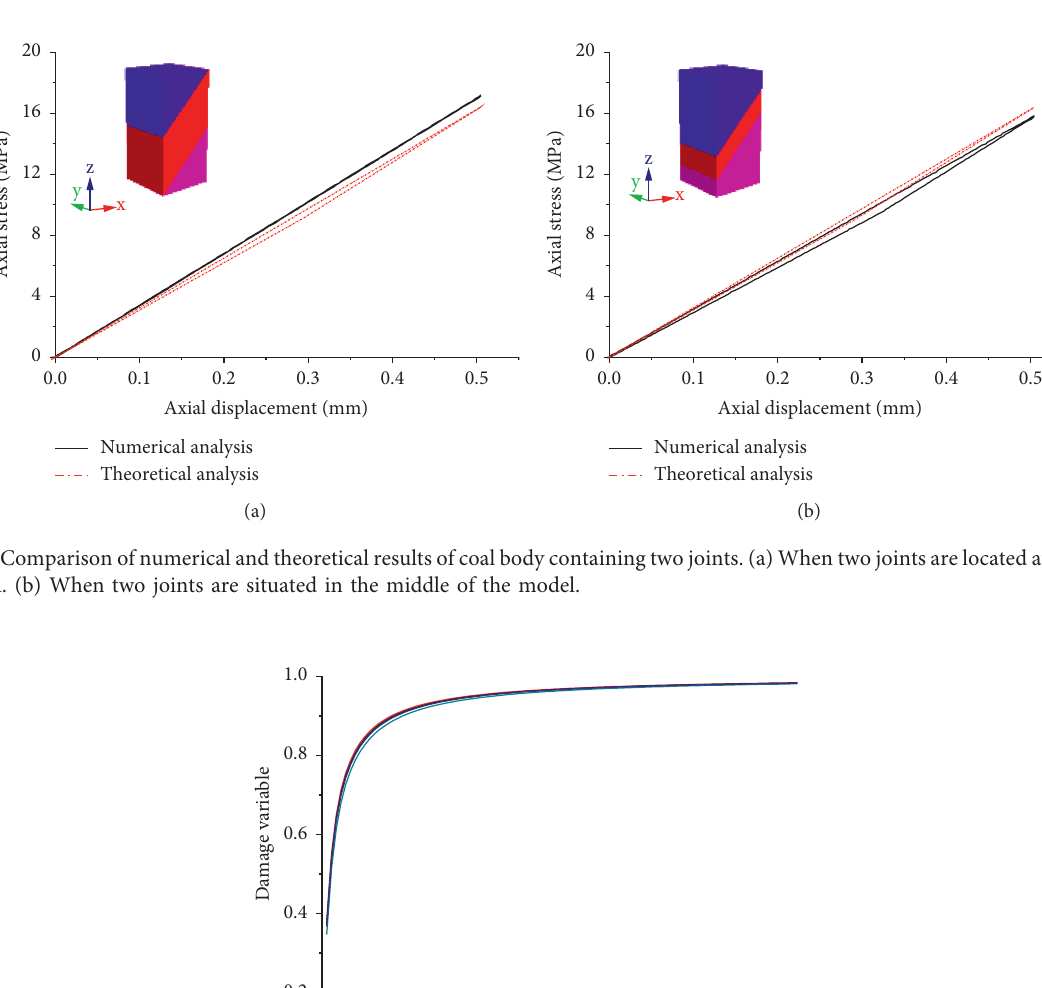
Table 1: The influence of the number of joints on the damage variable of coal containing through-going joints. Number of through-going joints